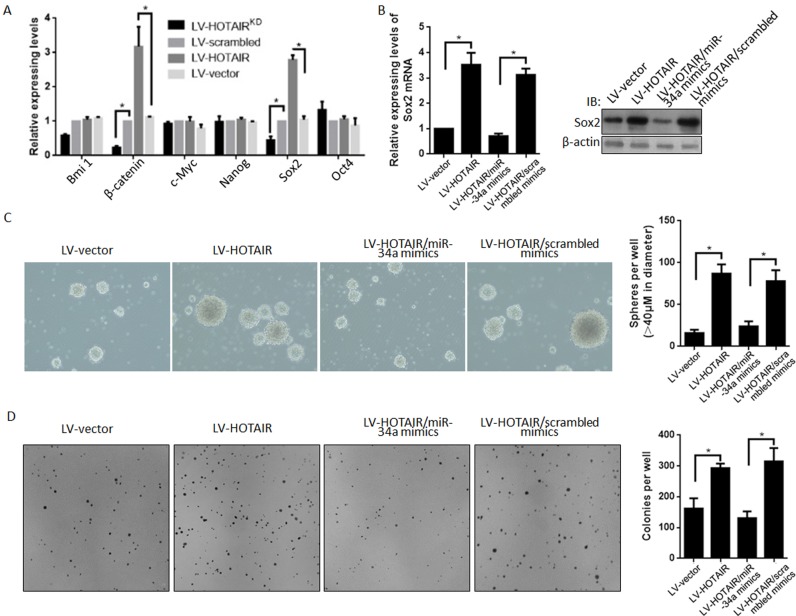
HOTAIR regulates the Sox2 expression via miR-34a and affects CSC self-renewal capacity.(A) The levels of Bmi1, β-catenin, c-Myc, Nanog, Sox2 and Oct4 expression in CSC-MCF7 cells transfected with LV-HOTAIRKD, LV-scrambled or LV-HOTAIR were detected by RT-qPCR. (B) The mRNA levels (Left panel) and protein levels (right panel) of Sox2 in CSCs were analyzed by RT-qPCR and semi-quantitative Western blotting. (C) To detect the effects of HOTAIR or miR-34a on CSC self-renewal capacity, a sphere formation assay was performed. (D) To detect the effects of HOTAIR or miR-34a on colony formation, a soft agar assay was performed in which the colonies per well were counted. *P<0.05.